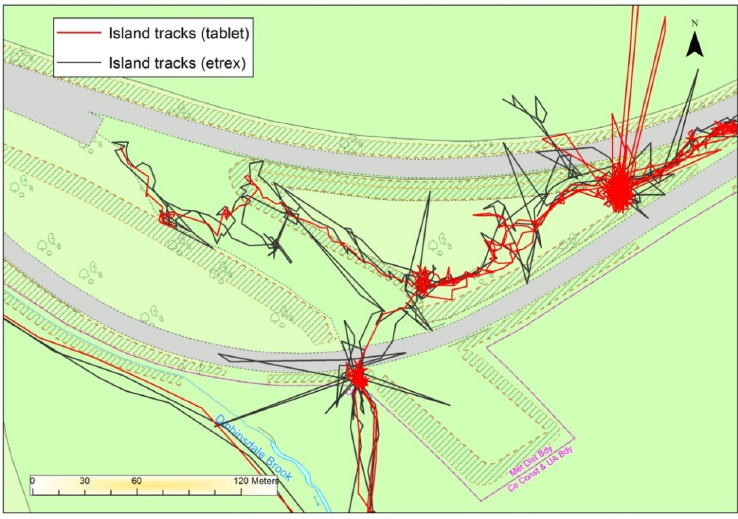
Figure 17. Map showing GPS tracks of island field visit, 22–23 August 2013 (1:1500) (Base map data: © Crown Copyright and Database Right [2013],Ordnance Survey (Digimap Licence)).